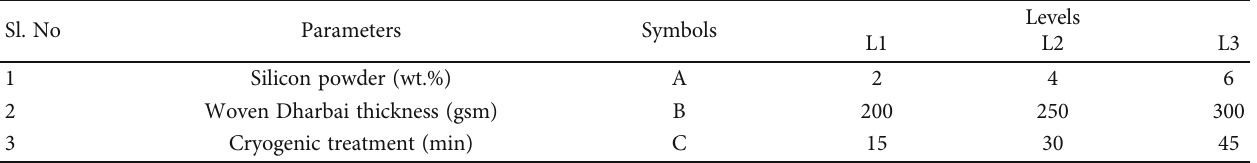
Table 1: Constrains and their stages for composite.